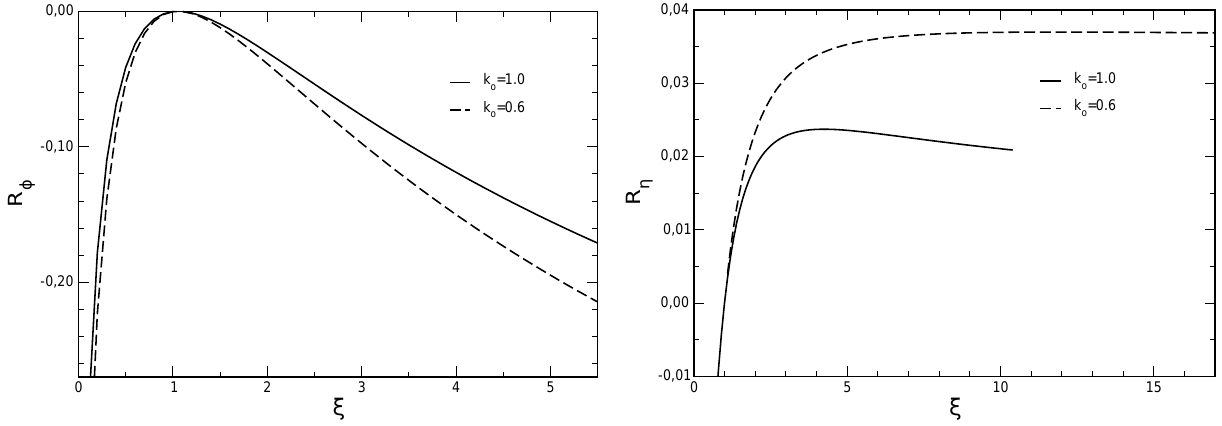
( T ) = k ( T, ξ ) plotted with the optimal parameter opt opt = 4 . 2 for k = 1 (purple) and ξ opt o ≈ 1 (from ξ = 1 . 054 for k = 0 . 1 to ξ opt opt o = 0 . 6 and k = 1 o o